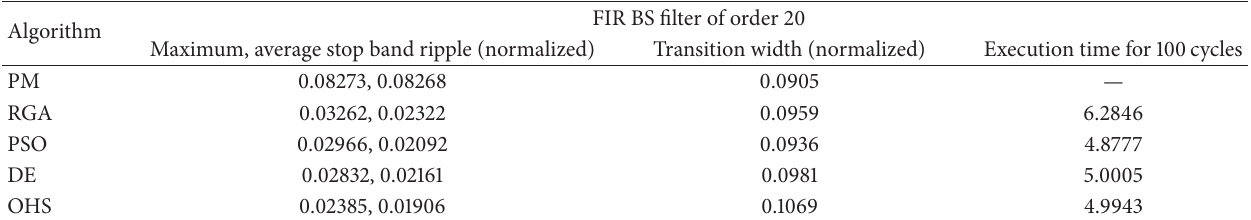
Table 10: Other comparative results of performance parameters of the FIR BS filter of order 20 for all algorithms.